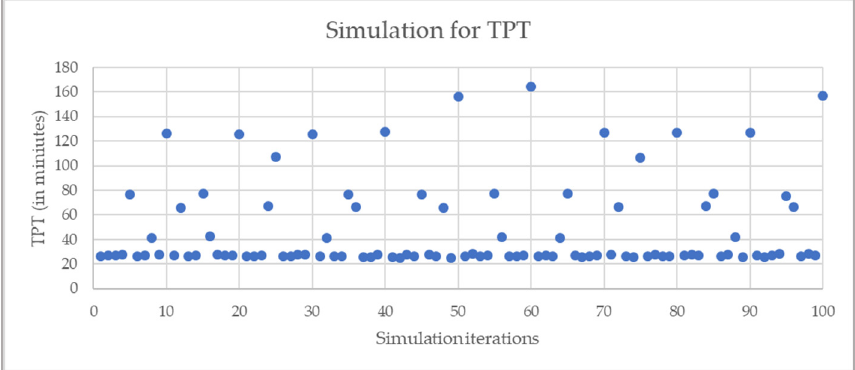
Figure 5. Total process times of the project.